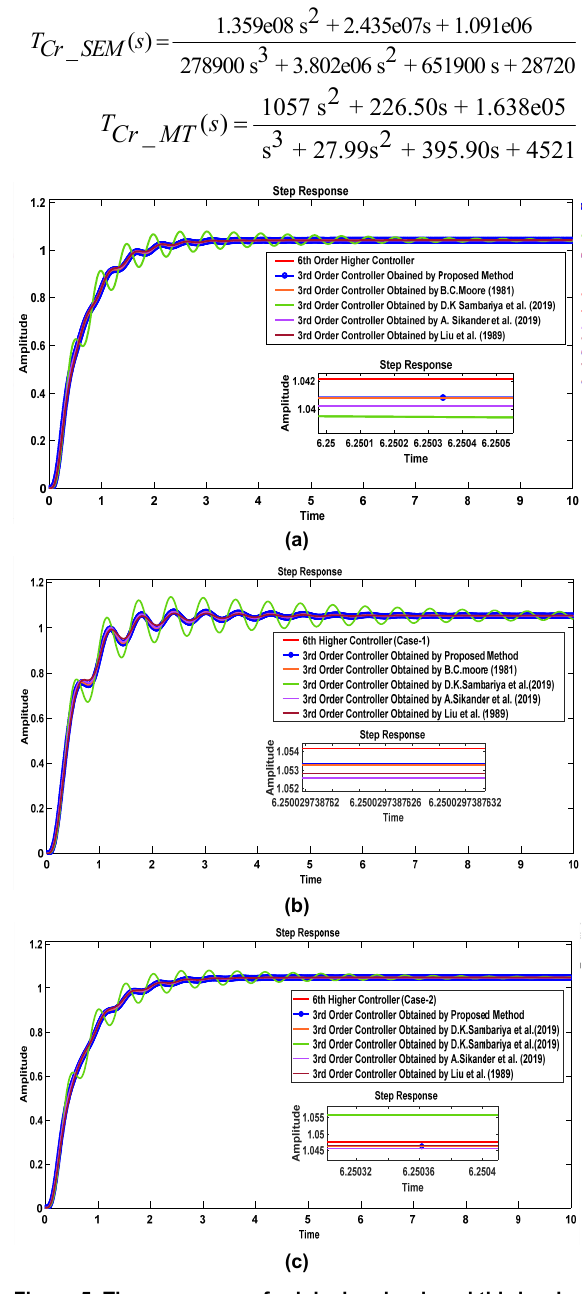
Figure 5. Time response of original and reduced third order controllers (a) with bicyrobo (b) with bicyrobo (Case-1) (c) with bicyrobo